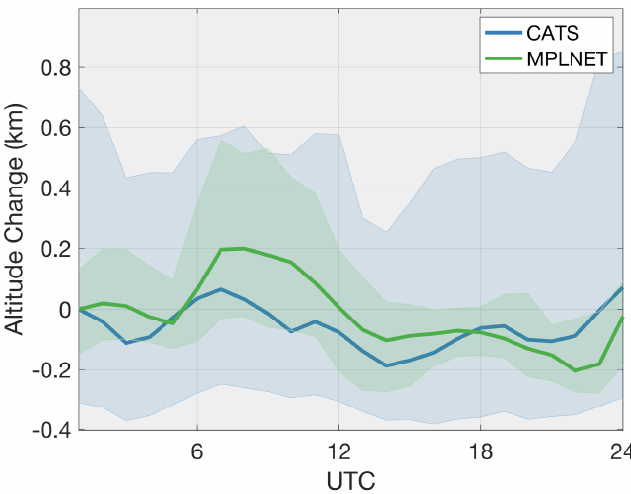
Figure 7. Observed diurnal cycle (difference from 0:00 UTC, local time UTC+8) in extinction-weighted altitudes for CATS and MPLNET for July, August, September, October, and November. Shaded region denotes the interquartile range (25–75% of